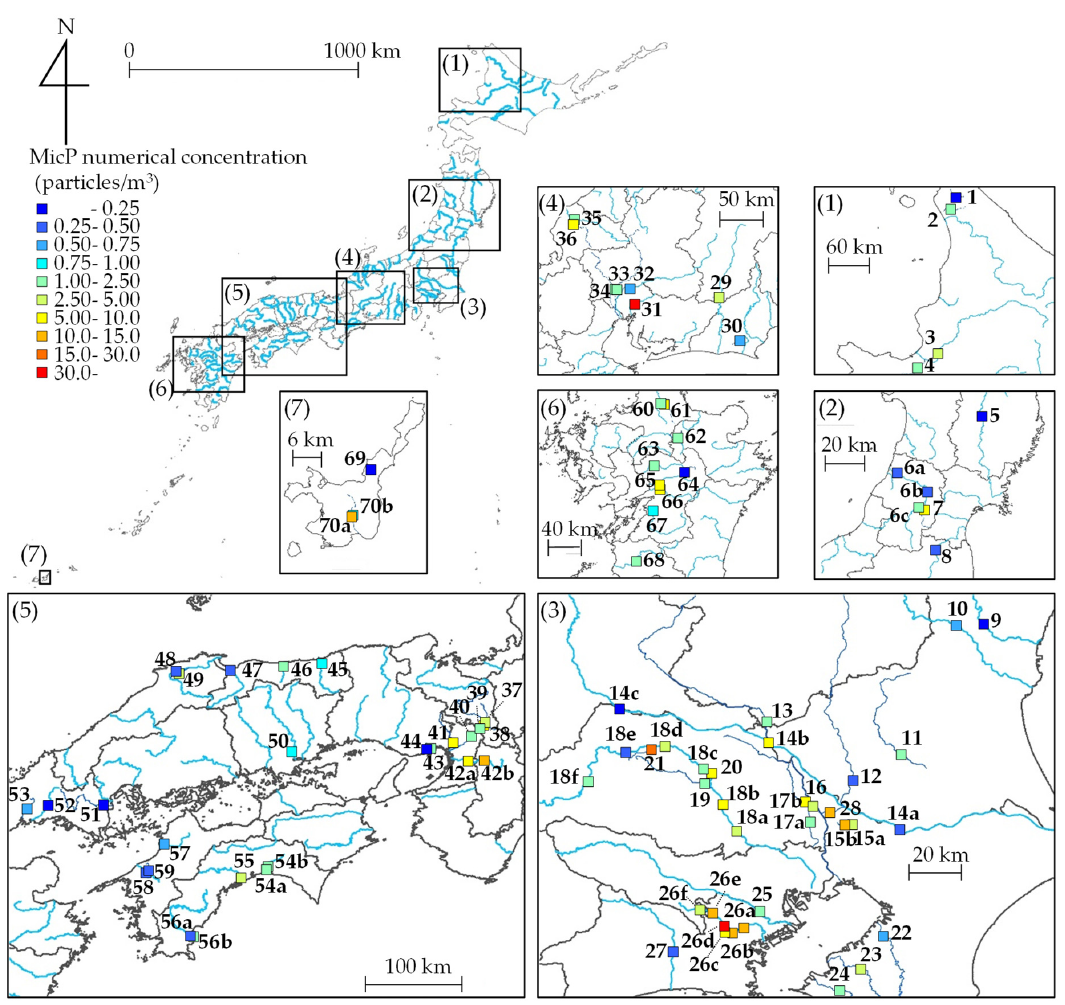
Figure 2. Measurement sites and measured MicP numerical concentrations in rivers.